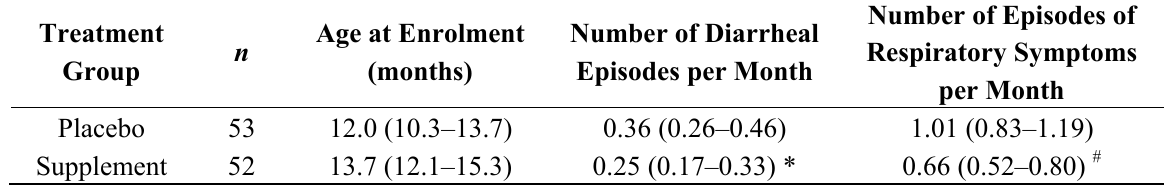
Table 5. Diarrhea and respiratory symptom episodes per month of follow